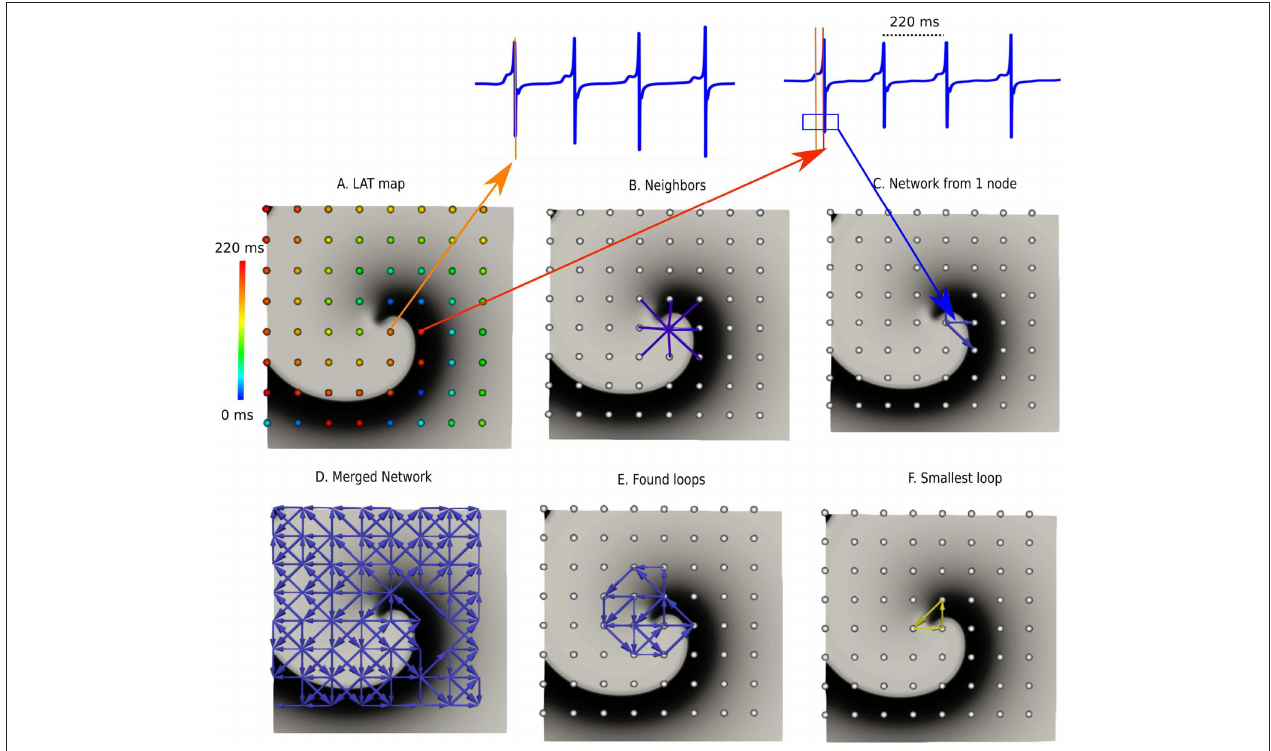
FIGURE 2 | DG mapping for a simulated rotor with a regular measuring grid. (A) The points are colored according to their LAT. (B) Shows an example of the 8 possible neighbors for a single grid point. (C) Represents the corresponding network for the same location. (D) The complete network is drawn from which all detected loops in the network are derived, as shown in (E) . The selected (smallest) loop among the bundle is shown in (F) .